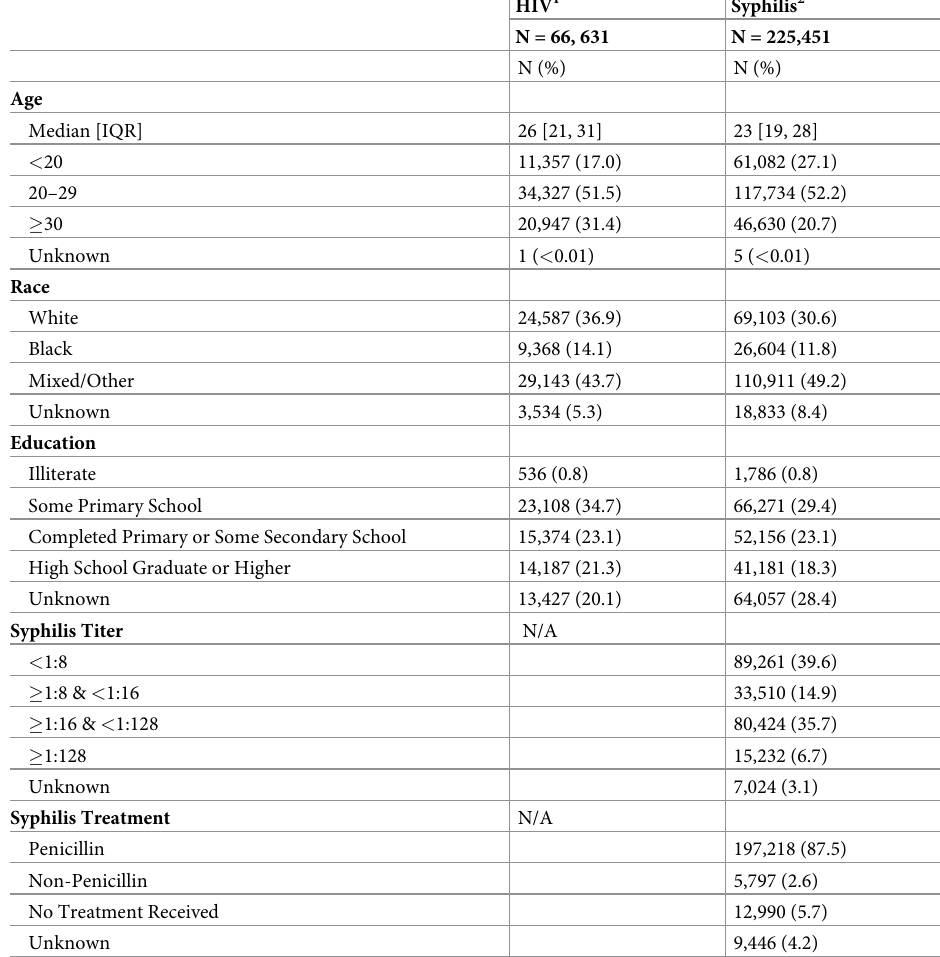
Table 1. Descriptive characteristics of women with maternal HIV and syphilis detected during pregnancy in Bra- zil from 2010 to 2018.